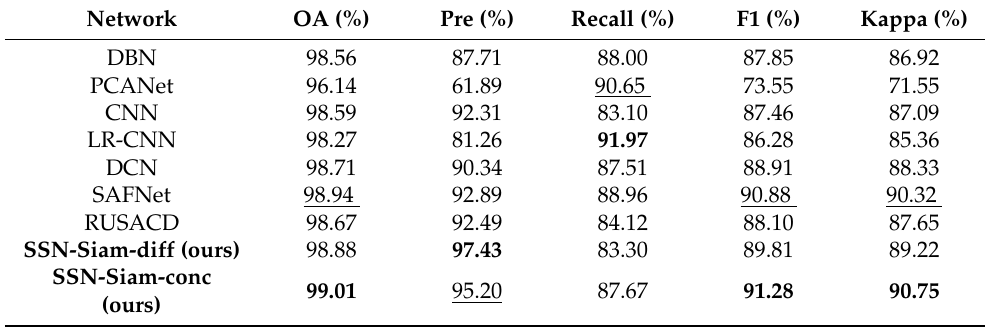
Table 9. Quantitative results of different methods used for the Farmland-A dataset.